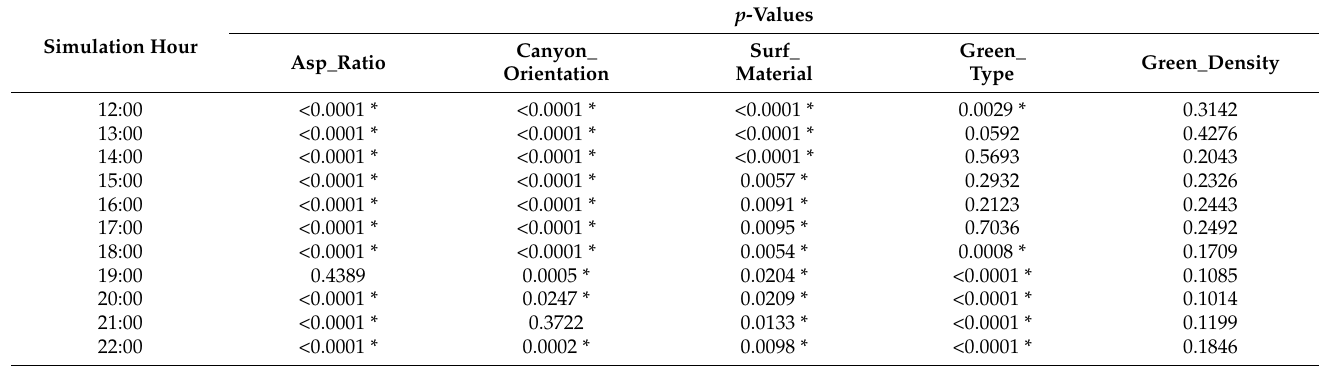
Table 2. p -values estimate ranges for the SRC estimates of air temperature at each timestep. p -Values